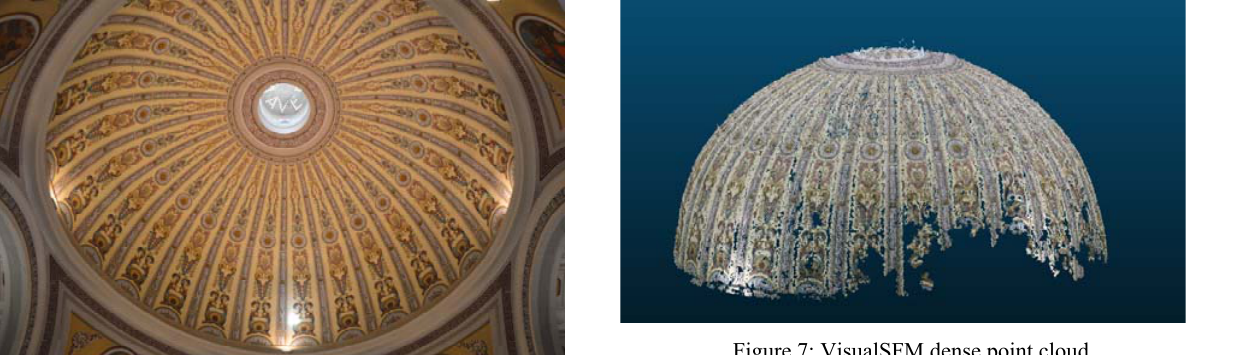
Figure 7: VisualSFM dense point cloud